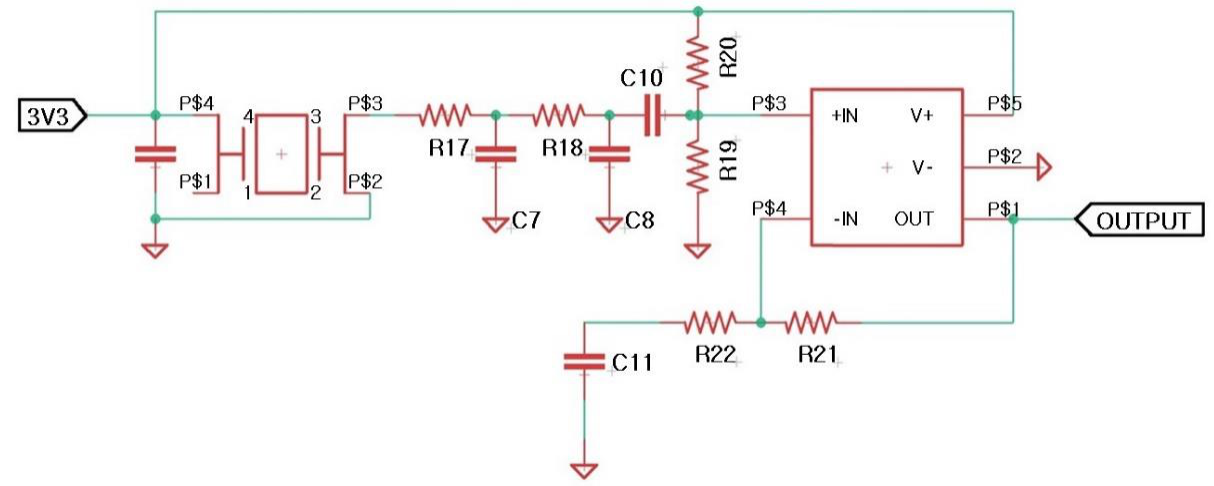
Figure 1. Circuit diagram of the electronics.